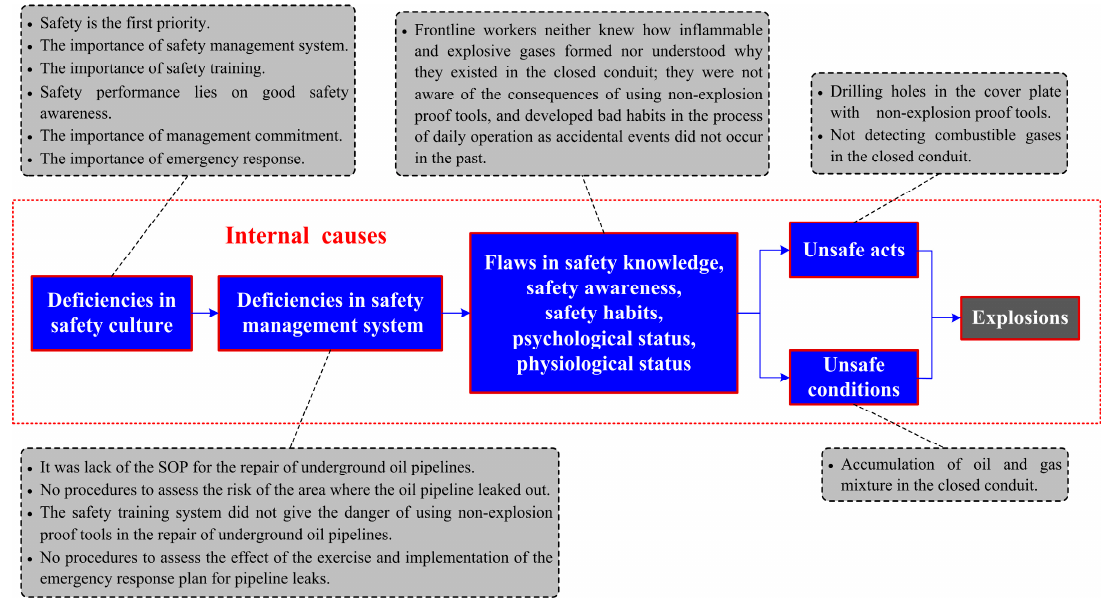
Figure 7. Causes analysis of explosions based on the accident causation model.